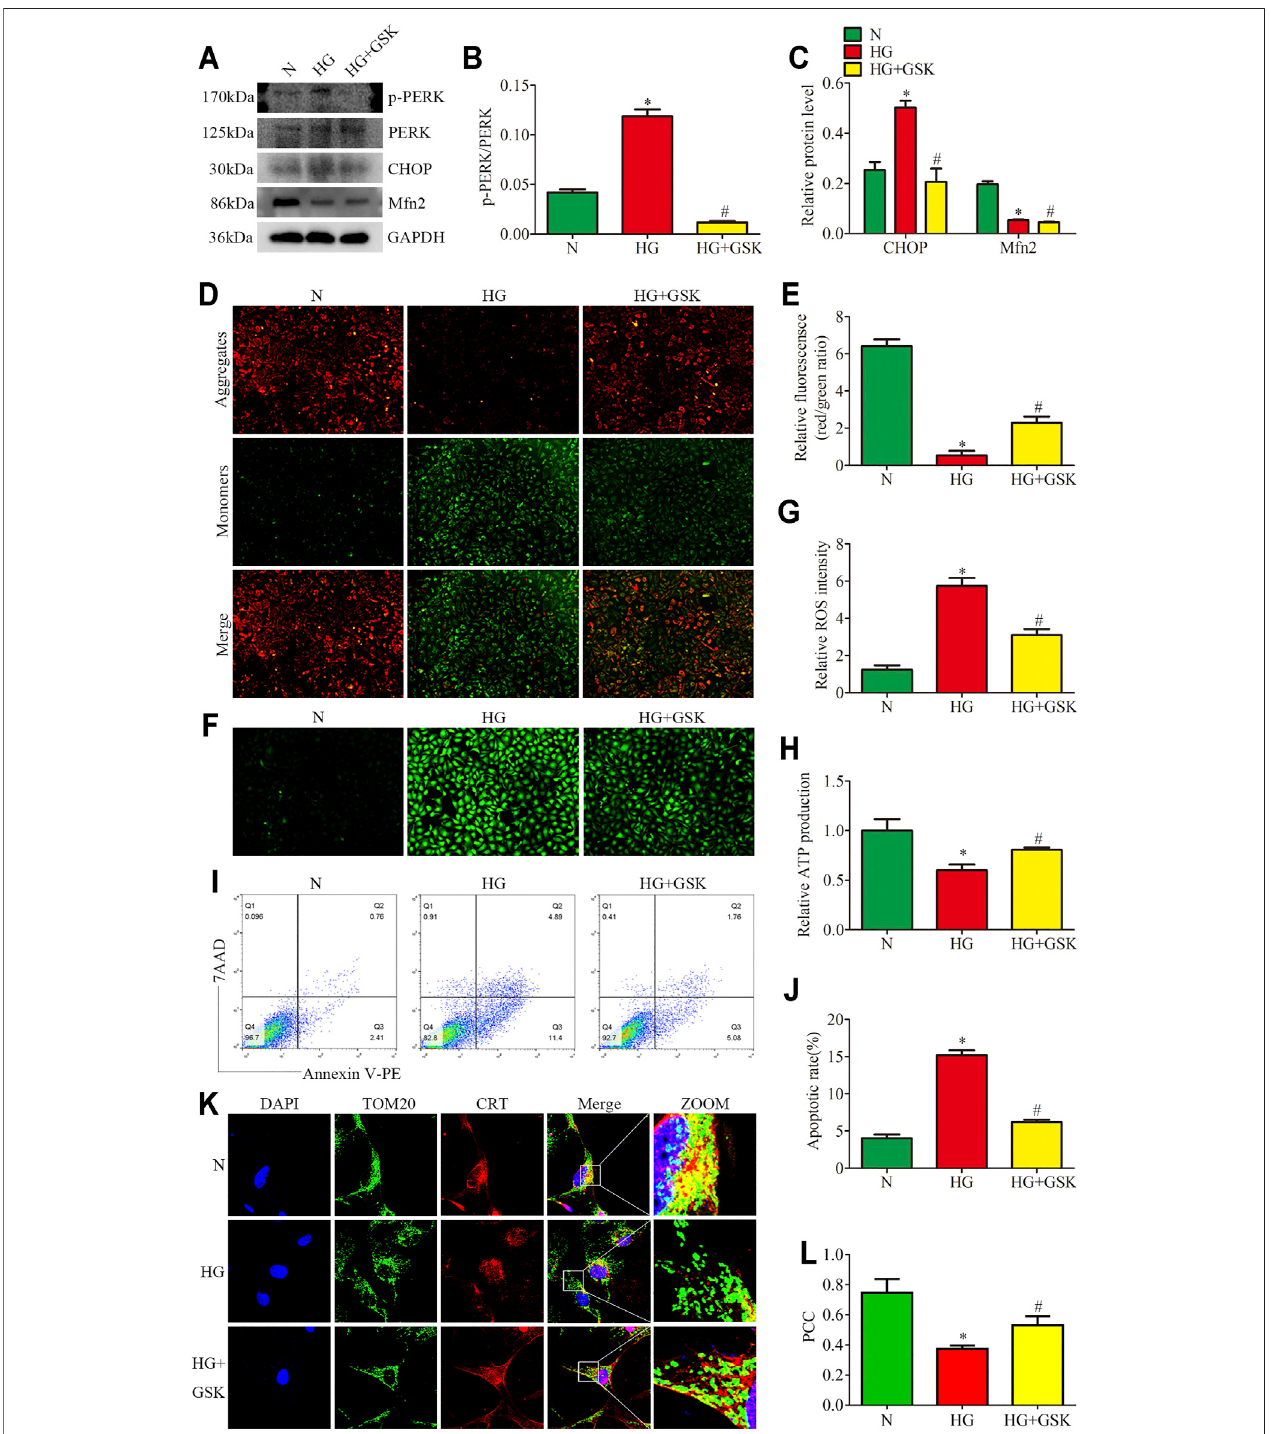
FIGURE 6 | Effects of PERK inhibition on HG-induced mitochondrial dysfunction and MAMs reduction. (A – C) Representative Western blots of p-PERK, PERK, CHOP, Mfn2 expression and quantitation per group (n (cid:1) 3). (D,E) Representative images of MMP in cultured podocytes by JC-1 staining and quanti fi cation per group (n (cid:1) 3) (original magni fi cation, × 100). (F,G) Representativeimages ofDCFH-DA fl uorescence (green) incultured podocytes toassess ROSproduction and quanti fi cation per group (n (cid:1) 3) (originalmagni fi cation, × 100). (H) ATPproduction wasassessed and quanti fi cation per group (n (cid:1) 3). (I,J) Flowcytometry analysisofapoptosis in cultured podocytes and quantitation per group (n (cid:1) 3). (K) Representative images of immuno fl uorescent staining of TOM20, CRT and DAPI in cultured podocytes per group (original magni fi cation, × 1,000) (L) Quantitation of PCC of TOM20 and CRT in Figure 6K per group (n (cid:1) 3). N (cid:1) 5 mM glucose for 24 h; HG (cid:1) 25 mM glucose for 24 h; HG + GSK (cid:1) 25 mM glucose and 20 μ M GSK2656157 for 24 h; NS, not signi fi cant; * p < 0.05 compared with podocytes cultured in normal conditions; # p < 0.05 compared with podocytes treated with HG.